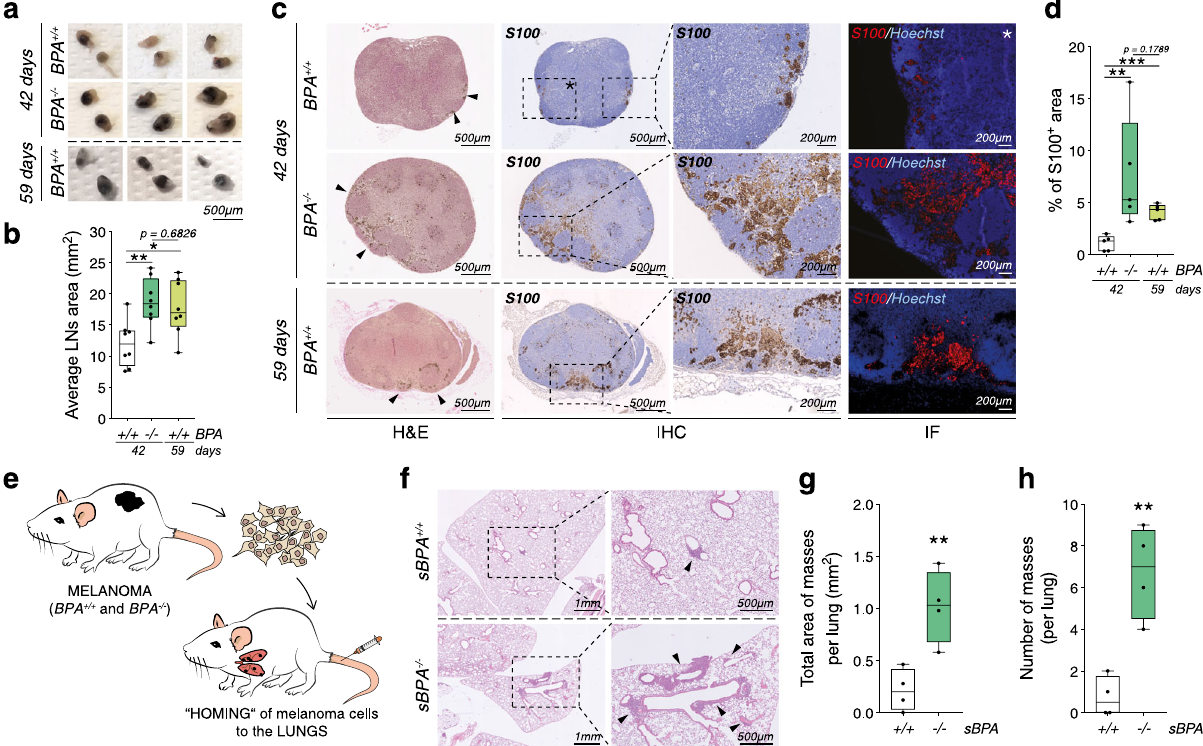
Fig. 4 Ambra1 deletion promotes melanoma metastases. a Macroscopic evaluation of inguinal lymph nodes (iLNs) collected when BPA − / − tumors reached maximum tolerated size (42 days, BPA + / + , n = 4; BPA − / − , n = 4) or at maximum allowed volume of BPA + / + tumors (59 days, n = 4). Three representative images are shown for each group. b Average area of iLNs was calculated at 42 ( BPA + / + , n = 4; BPA − / − , n = 4) and 59 ( BPA + / + , n = 4) days. Each point represents the average area of the iLNs for each mouse. Data are shown as mean ± SEM ( *p = 0.0172; **p = 0.0063, one-way ANOVA). c FFPE-iLNs sections were stained with H&E (left panels) and anti-S100 (IHC, middle panels; IF, rightmost panels). Areas of metastases are indicated by black arrows. Nuclei were counterstained with Hoechst in IF staining. Images are representative of each group ( n = 5). d Quanti fi cation of S100 IHC. Each data point represents the average percentage of S100 + area of the iLNs of each mouse± SEM ( n = 5, **p = 0.0079; ***p = 0.0002, one-way ANOVA). e Schematic representation of the syngeneic model for lung homing of melanoma cells; 0.25 × 10 6 cells/mouse were intravenously injected. f Perfused FFPE-lungs were stained with H&E and areas of cells homing indicated by black arrows. Images are representative of each group ( n = 4). g Total area ( **p = 0.0075) and h number of masses ( **p = 0.0025) in lungs of s BPA + / + ( n = 4) and s BPA − / − ( n = 4) mice were quanti fi ed (two-tailed unpaired t -test, sBPA − / − vs. sBPA + / + ). Box-and-whisker plots shown in b , d , g , h ) represent values from minimum to maximum. Top and bottom whiskers denote upper (Q 3 ) and lower (Q 1 ) quartiles, respectively. Boxes refer to interquartile ranges. Medians are denoted as horizontal line in the middle of the